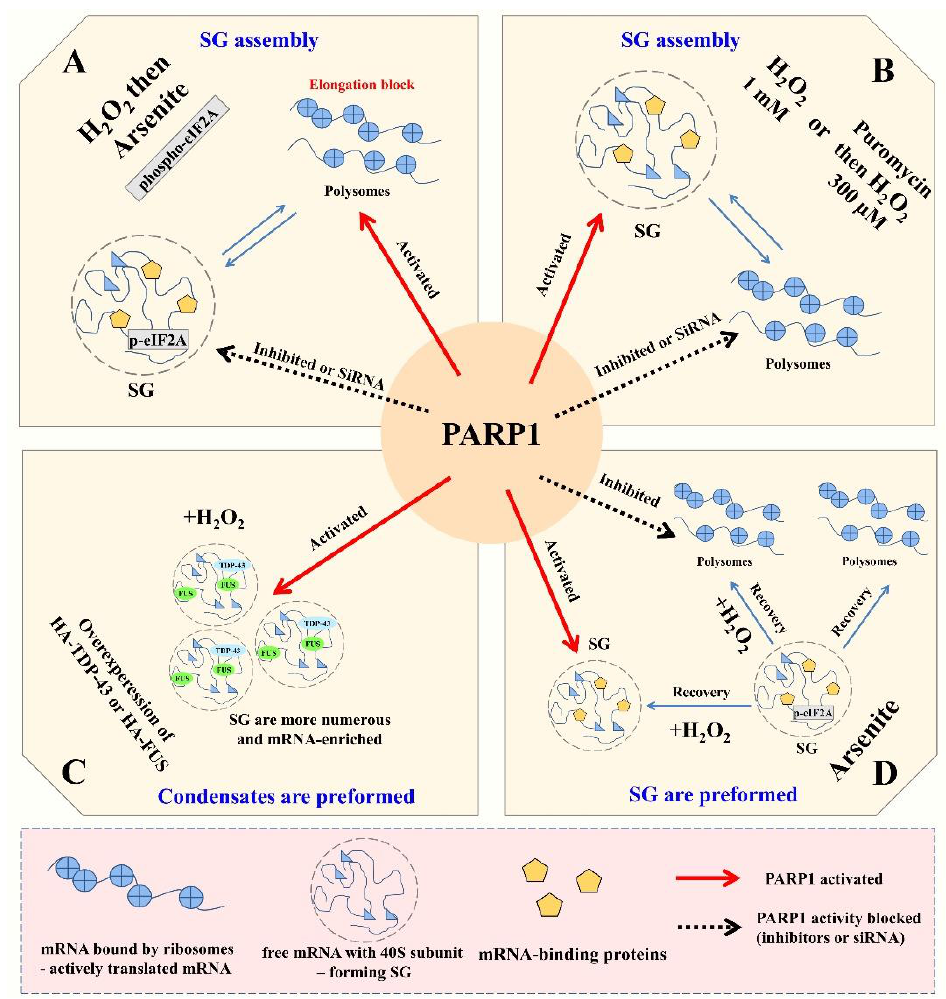
Figure 6. PARP1 could regulate different stages of mRNA-rich granules ’ metabolism in cytoplasm. ( A ) PARP1 activation prevents polysomal disassembly induced by arsenite treatment and blocks formation of SGs. ( B ) PARP1 activation stimulates formation of SGs at a high concentration of H 2 O 2 or if polysomes are destabilized with puromycin. ( C ) PARP1 activation enhances the formation of TDP-43- and FUS-rich SGs under H 2 O 2 -induced stress conditions. ( D ) PARP1 activation upon H 2 O 2 exposure prevents disassembly of arsenite-induced SGs.